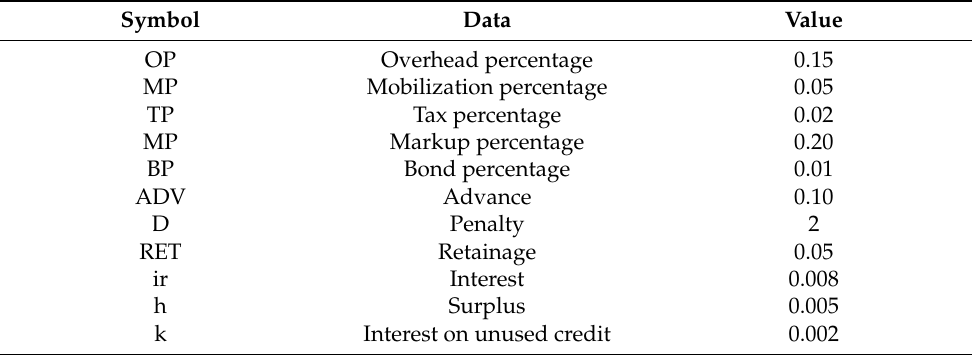
Table 6. Financial data and contract terms for the test